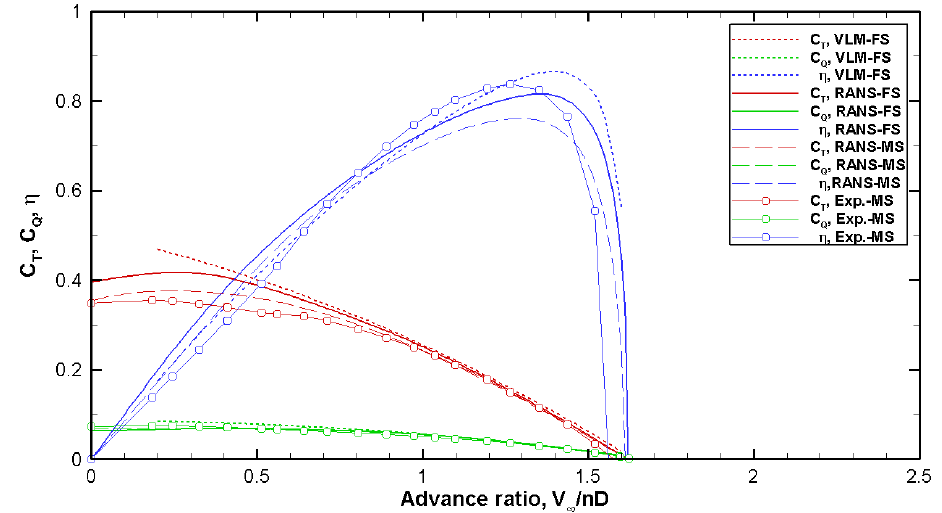
Figure 13. Propeller-performance curve for pitch angle = 34°.